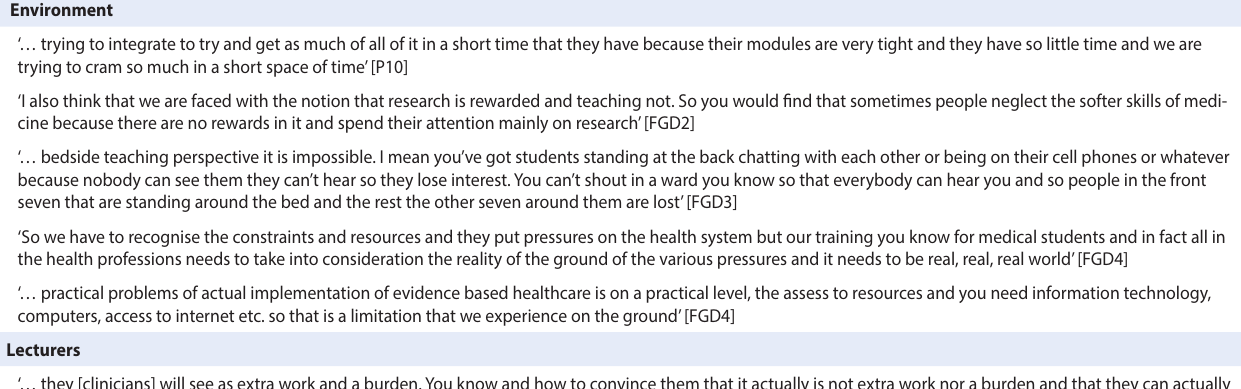
Table 3: Issues to consider in planning and implementing EBHC teaching and learning Environment